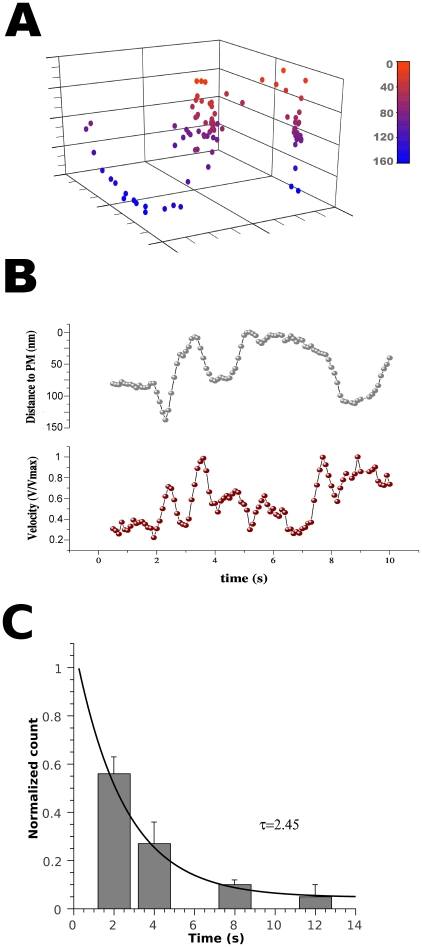
Diffusional description in 4D.
A, time sequence for a moving particle in three dimensional space (x,y,z) during 20 s. The z axis was calibrated using fluorescent beads of known size (see methods). Depicted particle goes from the inside of the cell (blue colors) to the plasma membrane (red colors), and jump from one corral to the next. The arrow indicates the starting point for the trajectory. B, Smoothed plots for the same trajectory, showing the correlation between the position on the z axis (upper panel) with particles' change in velocity (lower panel). C, Histogram for the residence time at the maximal fluorescence intensity. The solid line correspond to a first order exponential decay with an associated time constant indicated (n = 20).